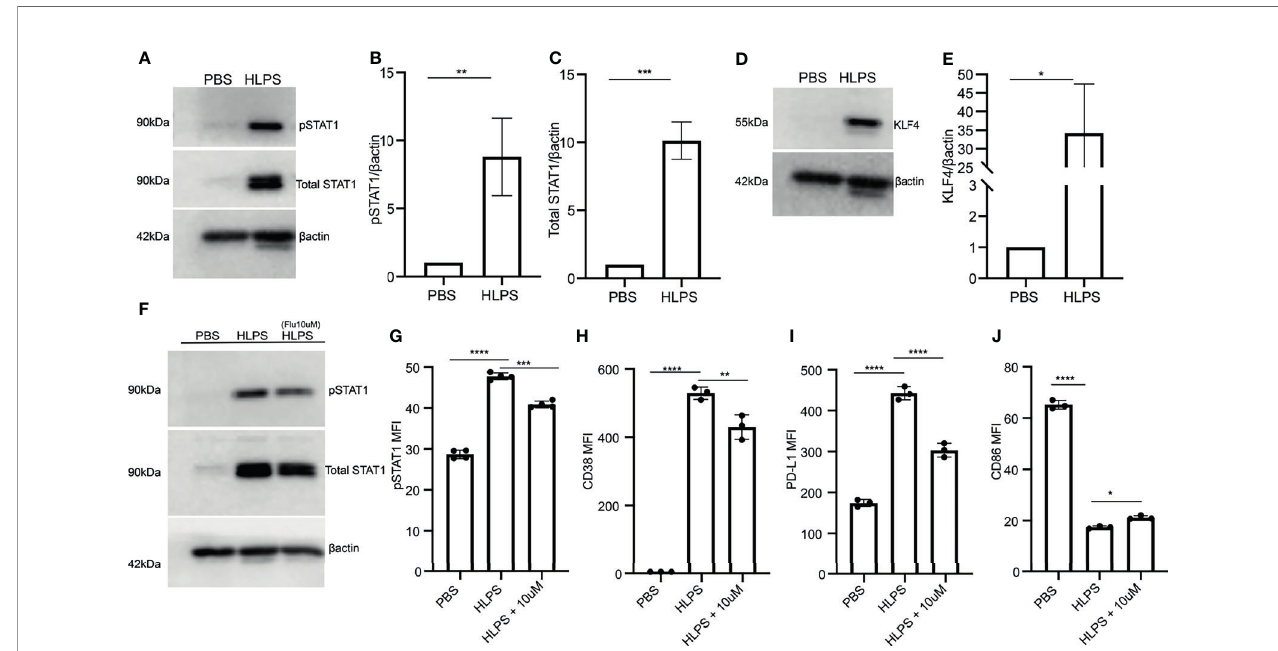
FIGURE 4 | Exhausted monocytes exhibit sustained activation of STAT1. (A – E) BMDMs were stimulated with PBS or high dose LPS (100 ng/mL) for 5 days. The levels of phosphorylated STAT1 and total STAT1 were determined by Western blot, n=3. (A) . The relative levels of pSTAT1 (B) and STAT1 (C) were normalized to b - actin. The level of KLF-4 was determined by Western blot, n=3 (D) , and the relative level was normalized to b -actin (E) . (F – J) BMDMs were pre-treated with STAT1 inhibitor (Fludarabine 10 uM) on Day 0 for 2 hours, followed by stimulation with PBS or high dose LPS (100 ng/mL). The levels of pSTAT1 and STAT1 were determined using Western blot, n=3 (F) and fl ow cytometry, n=3 (G) . The expressions of CD38 (H) , PD-L1 (I) and CD86 (J) were analyzed with fl ow cytometry, n=3. The data are representative of at least three independent experiments, and error bars represent means ± SEM. *p < 0.05, **p < 0.01, ***p < 0.001, ****p < 0.0001, (B, C, E) Student ’ s t test and (G – J) one-way